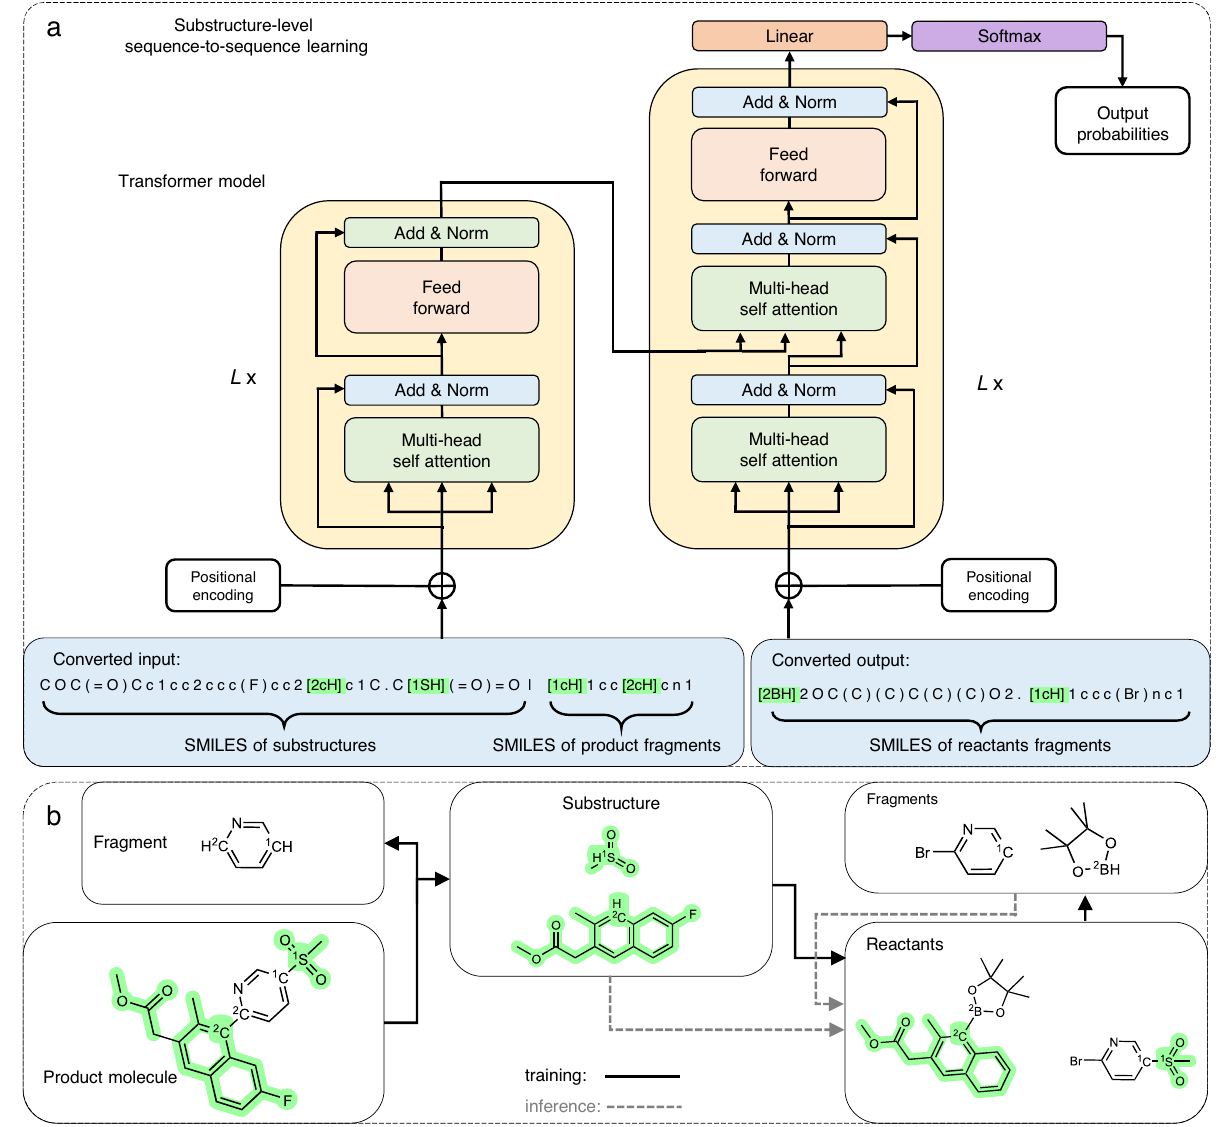
Fig.8|Substructure-levelsequence-to-sequencelearning. BoththeTransformer encoderanddecoderhave L identicalblocks.Thevirtualnumberlabeledatomsand substructures are highlighted in green. During training, the product side (input) is converted to substructures and fragments from the product, the reactants side (output)isconvertedtofragmentsfromreactantsonly. “ ∣ ”